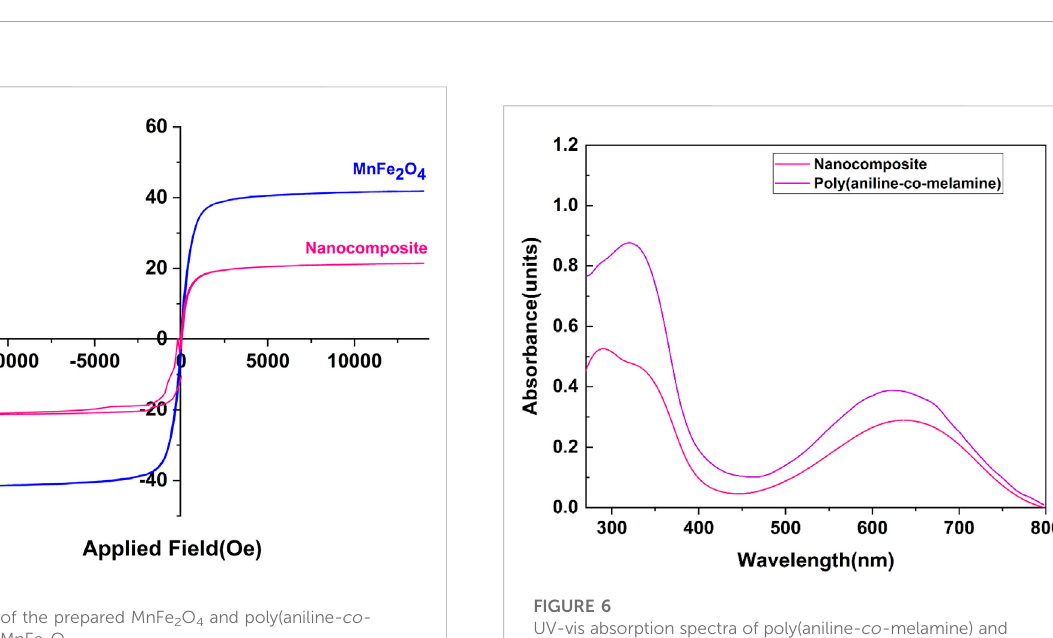
UV-vis absorption spectra of poly(aniline- co -melamine) and poly(aniline- co -melamine)@MnFe 2 O 4 in DMSO